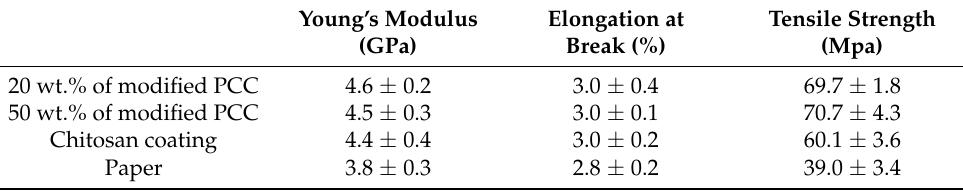
Table 6. Mechanical properties of paper and coated paper.